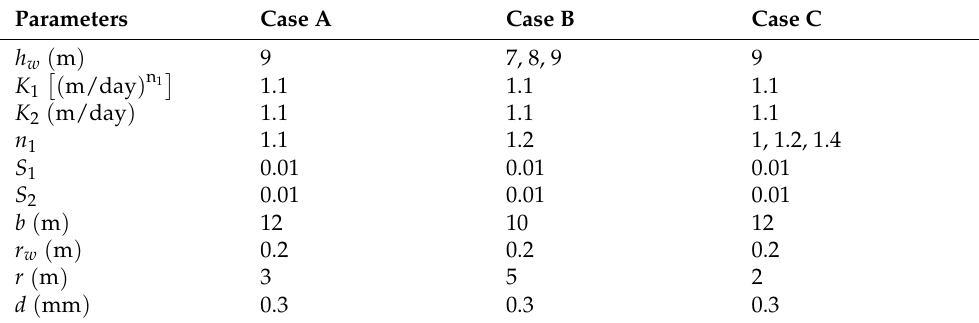
Table 1. Parameter values for hypothetical cases.